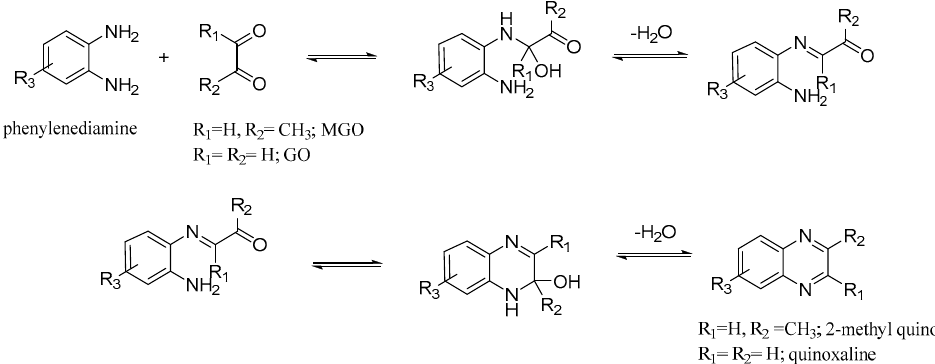
Figure 1. Reaction of dicarbonyl compounds (here methylglyoxal) with phenylenediamines (here o -phenylenediamine) as starting material. After addition of the two compounds, water is eliminated to form the mono-imine ( top ), which in a second addition-elimination cycle forms the quinoxaline ( bottom ).